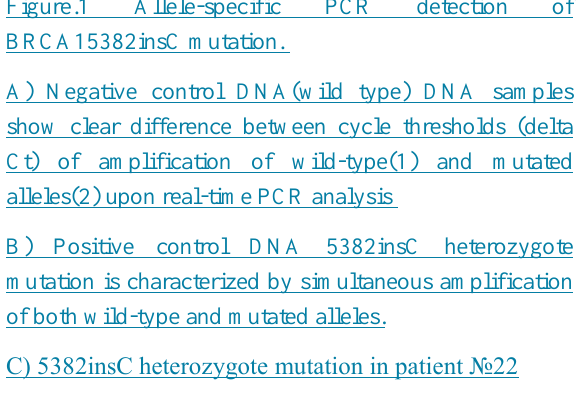
Table 2. The frequency of BRCA1 and BRCA2 mutations in patients with breast cancer and control group